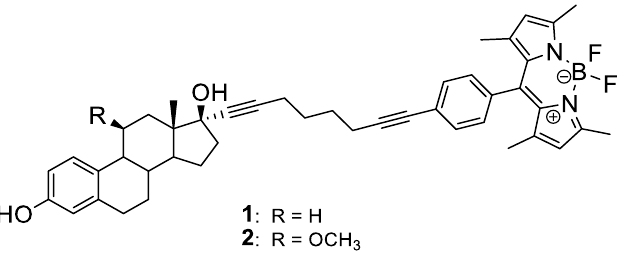
Scheme 1. Structures of estradiol-BODIPY conjugates.